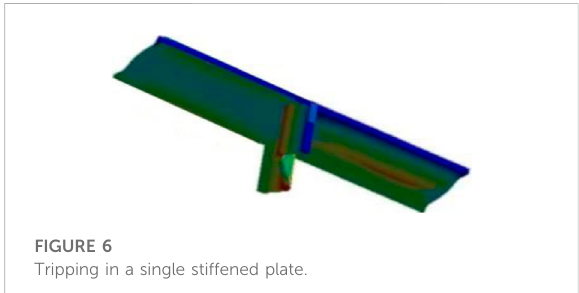
FIGURE 6 Tripping in a single stiffened